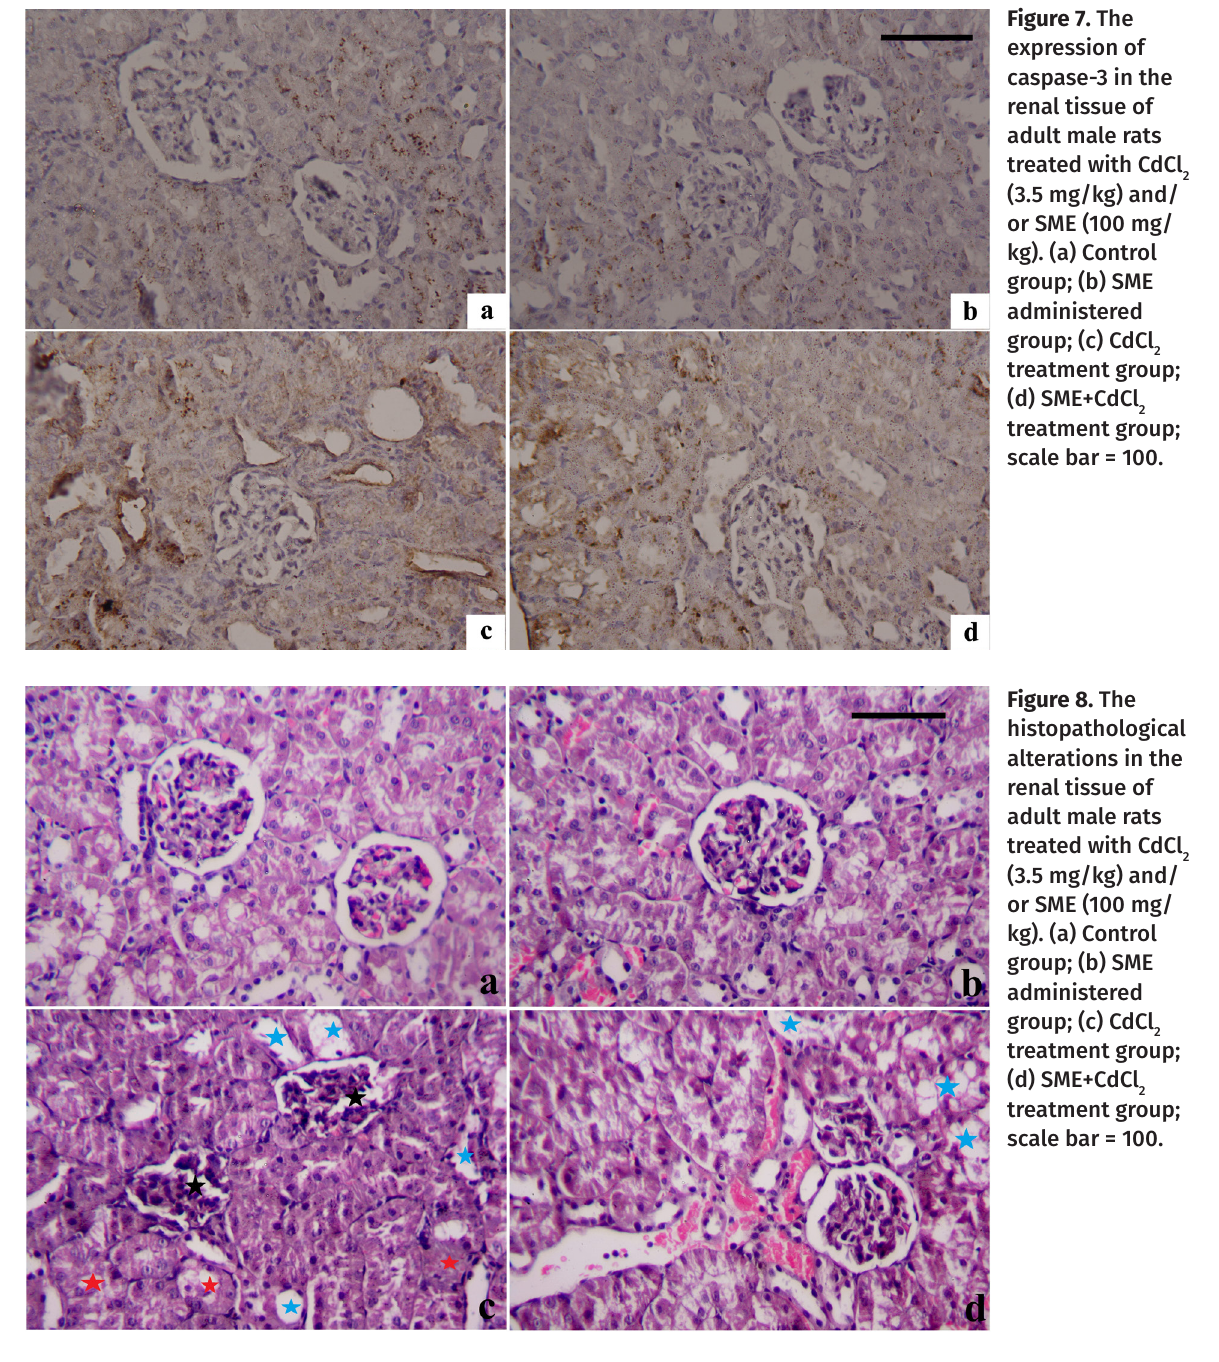
Figure 7. The expression of caspase-3 in the